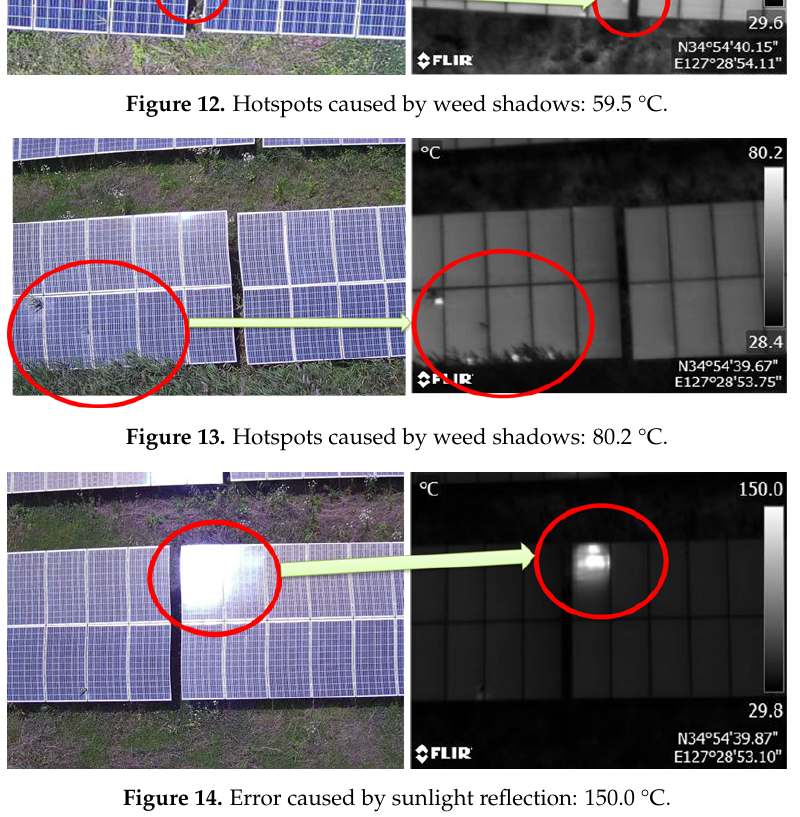
Figure 14. Error caused by sunlight reflection: 150.0